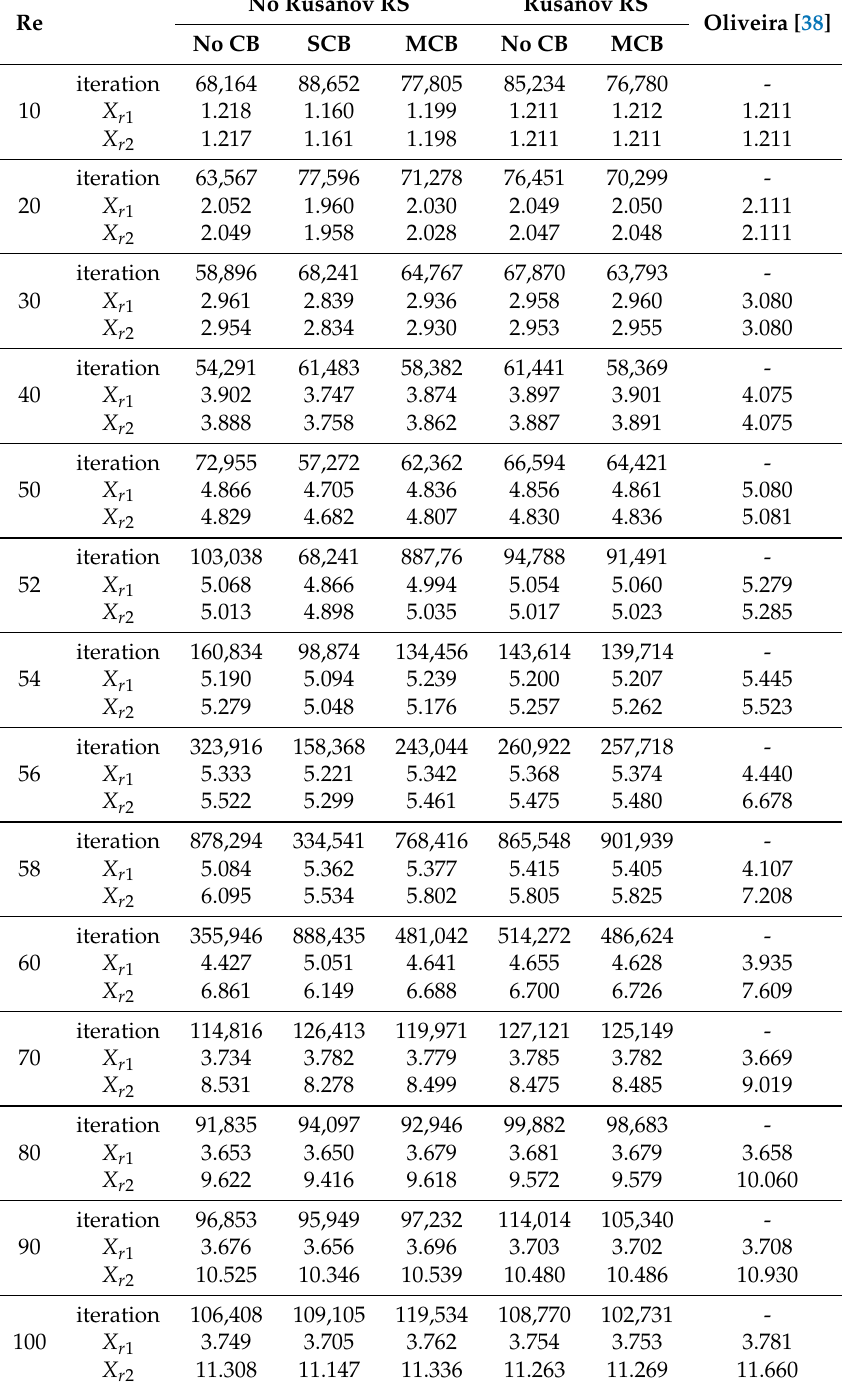
Table 6. Prediction of the reattachment length X r 1 and X r 2 and number of iterations required for convergence for different Reynolds numbers using the FSAC-PP method for various combinations of CB schemes and the Rusanov Riemann